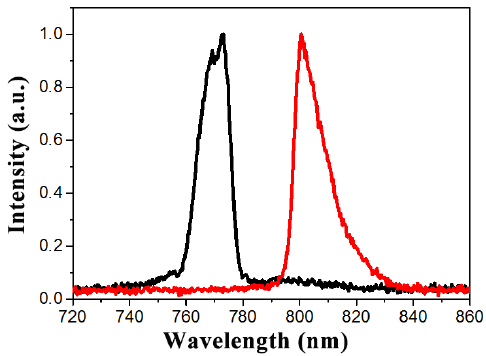
Figure 11. The spectra of Beam 1 (black), Beam 2 (red) [62].